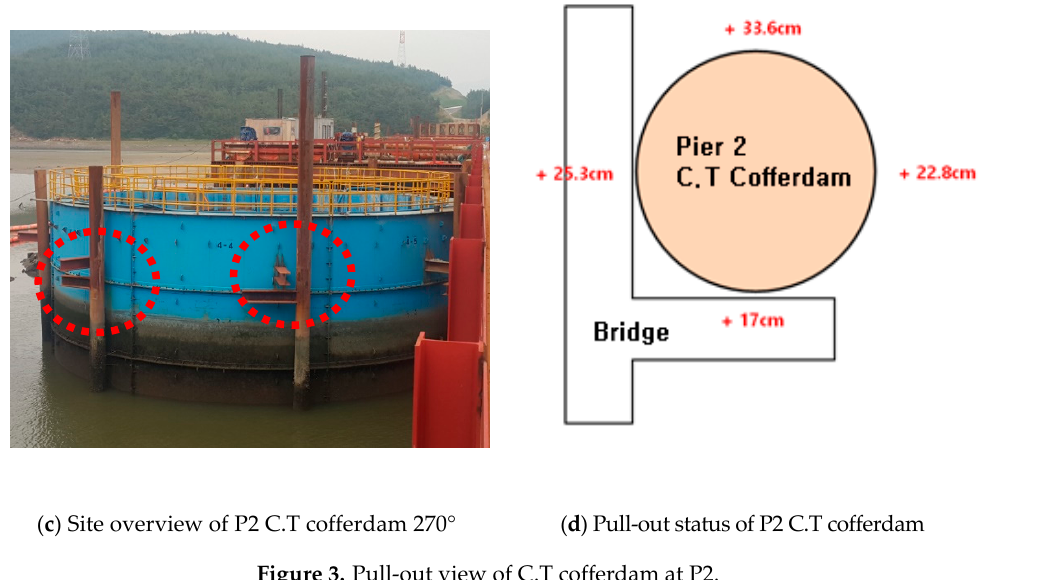
Figure 3. Pull-out view of C.T cofferdam at P2.